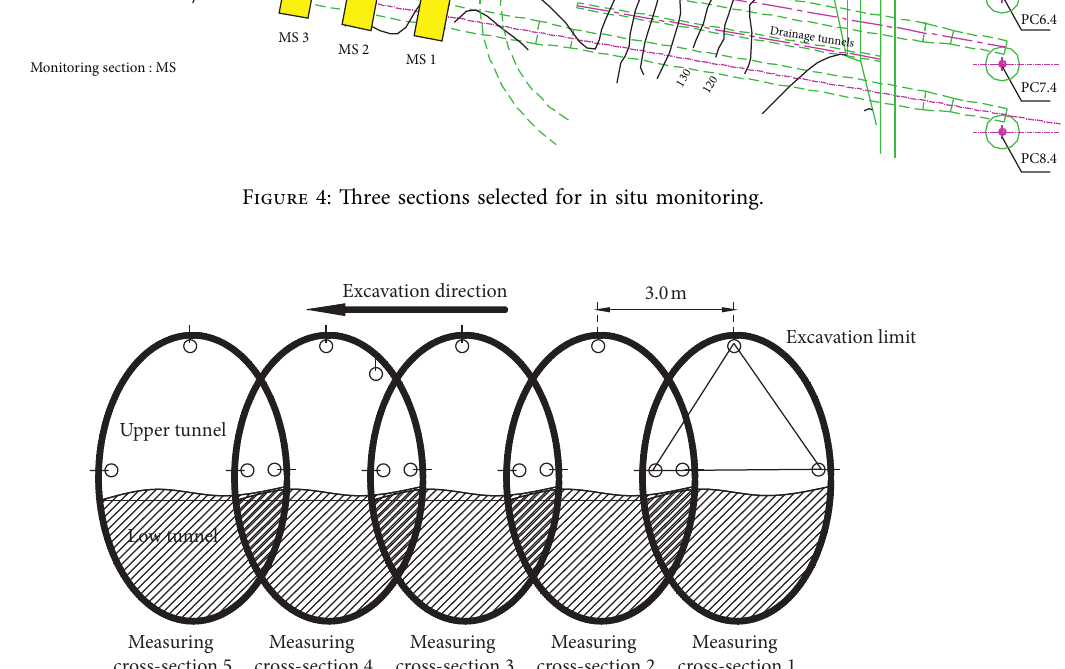
Figure 5: Measuring cross-section and displacement ring.